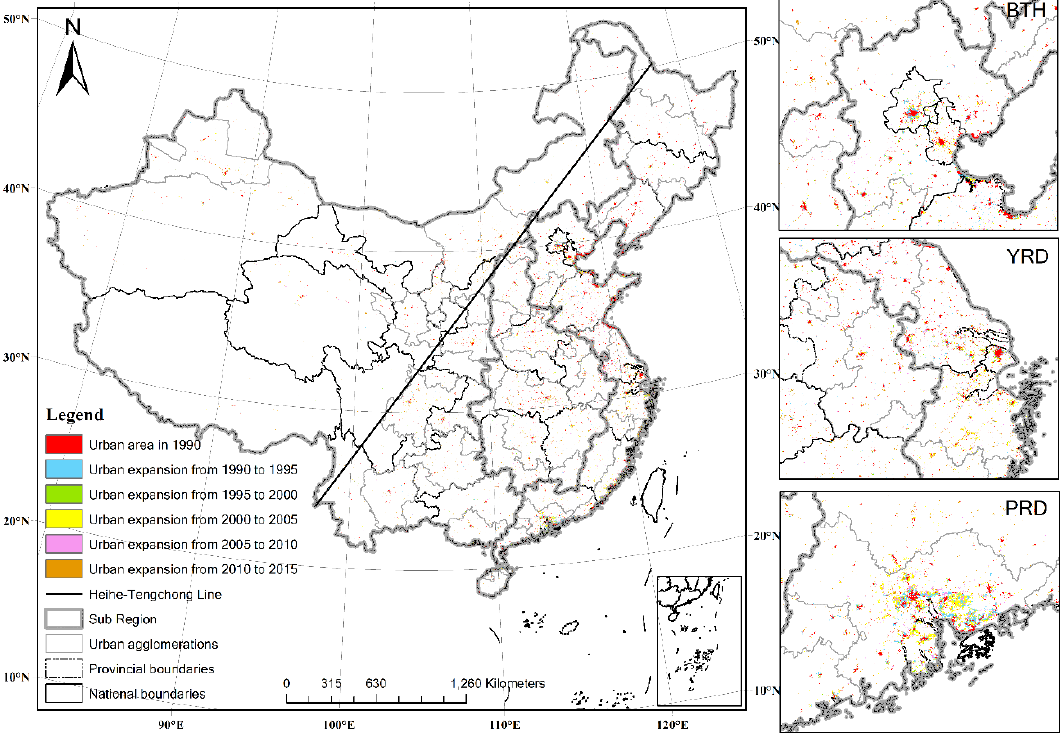
Figure 3. Urban expansion in China during 1990 – 2015.